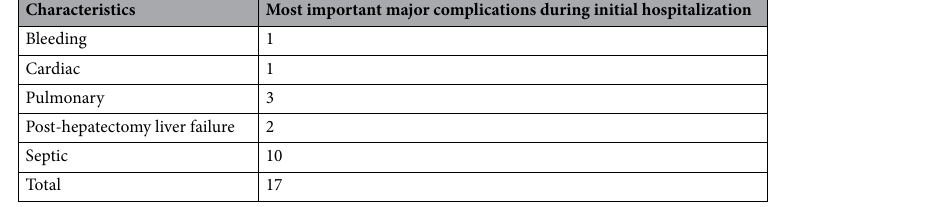
Table 3. Perioperative complications.